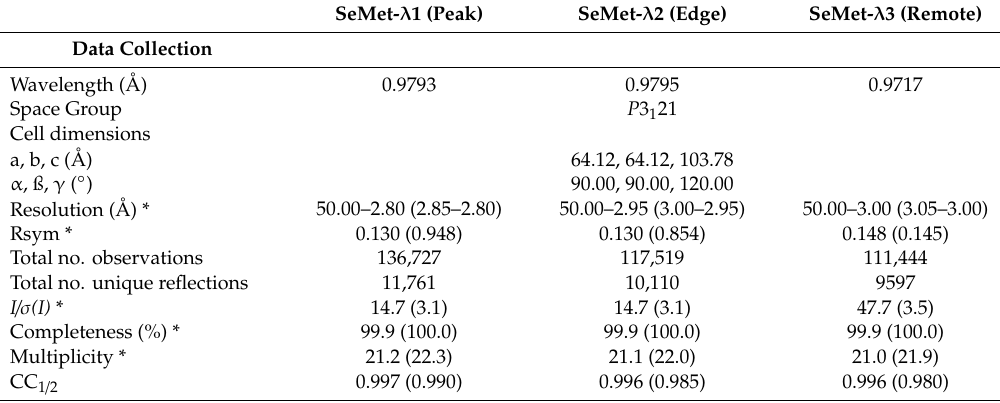
Table 1. Multi-Wavelength anomalous di ff raction phasing statistics.